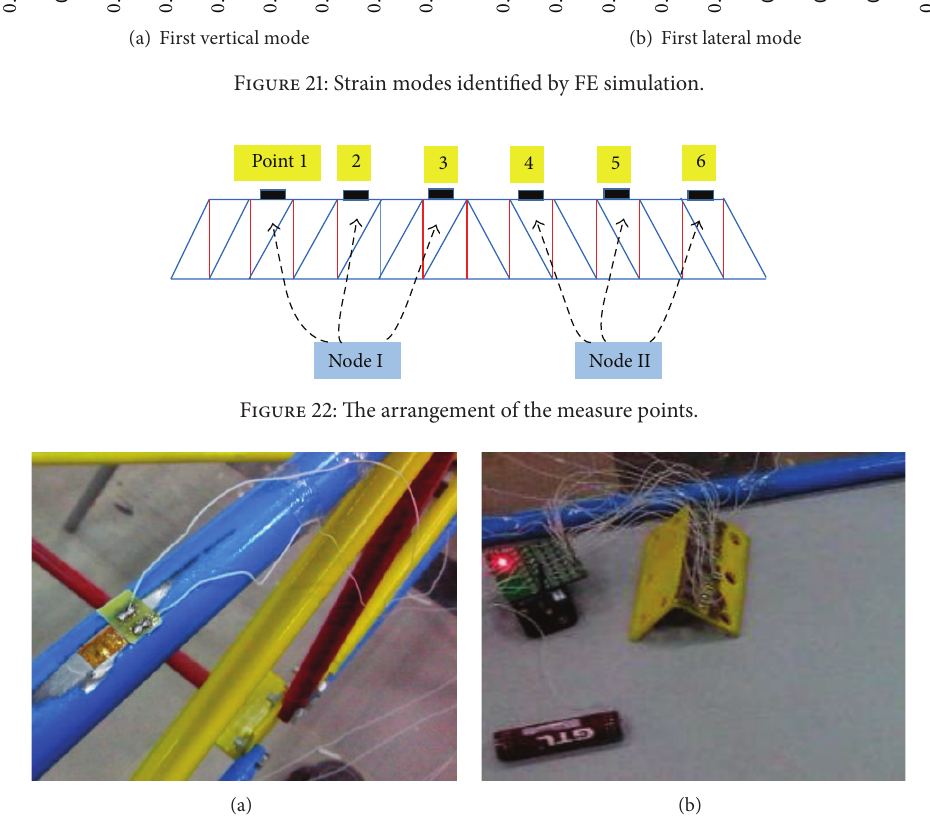
Figure 23: Experiment: (a) resistance strain gauge and (b) compensated strain